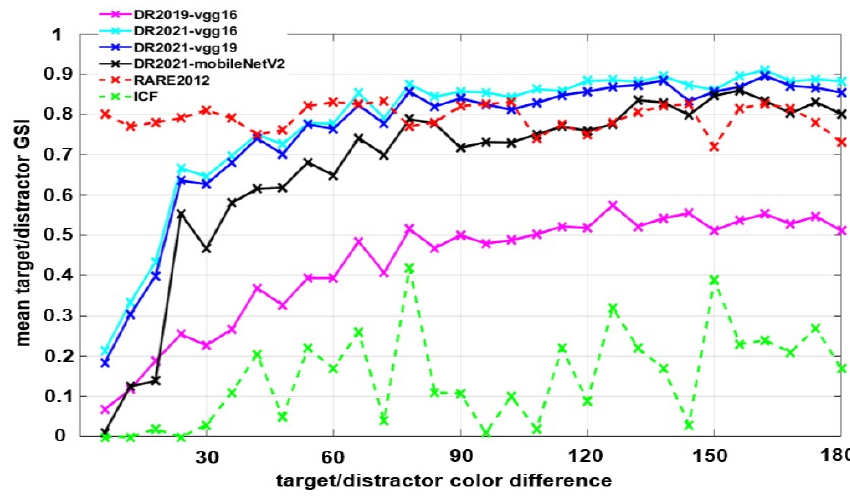
Figure 12. The GSI score for color target/distractor difference. Best classical (dotted red line) and best deep-based (dotted green line) along with the DeepRare family models.